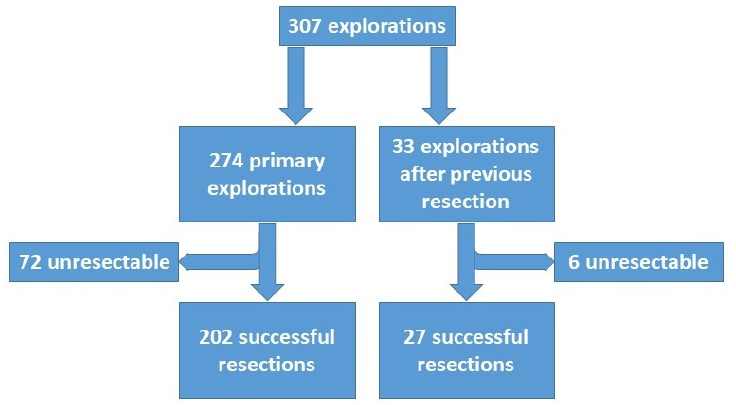
Figure 2. Flowchart of all explorations. Further subdivision in primary and repeated